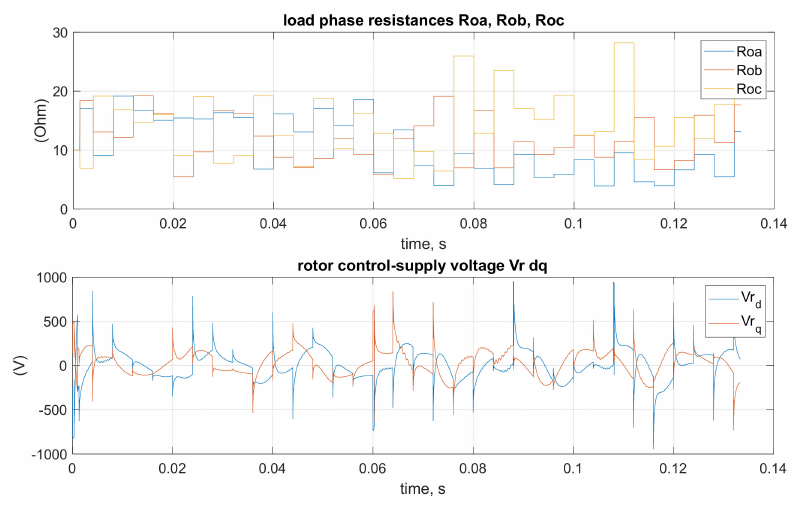
Figure 6. The voltage V r , powering the rotor, generated by the RSC in the dq coordinate system, against the changes in resistance of the load phases in the islanded grid.